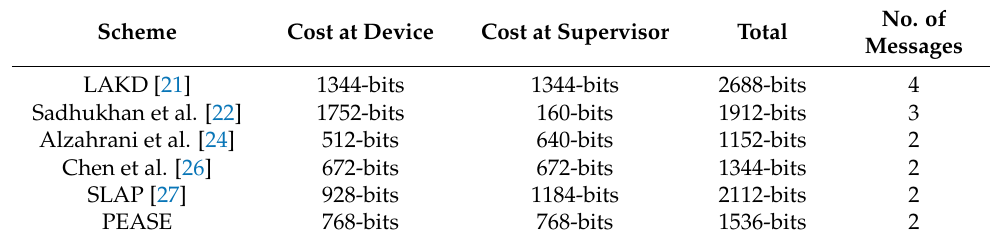
Table 8. Comparison of communication overhead.